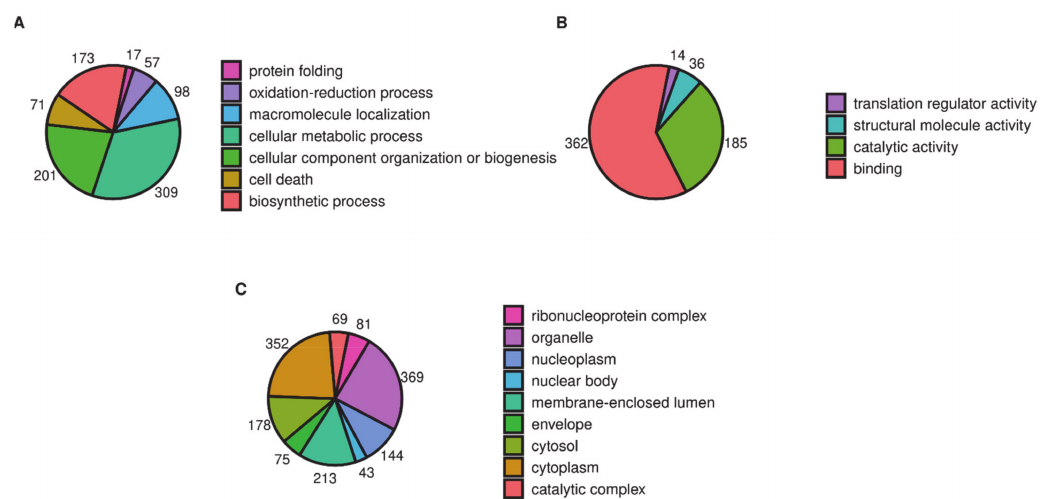
Figure 1. Functional classification of up- and downregulated proteins in PMJ2-R cells according to the Gene Ontology database: Biological process ( A ), molecular function ( B ) and cellular localization ( C ). Pie charts were built using significantly enriched GO terms.